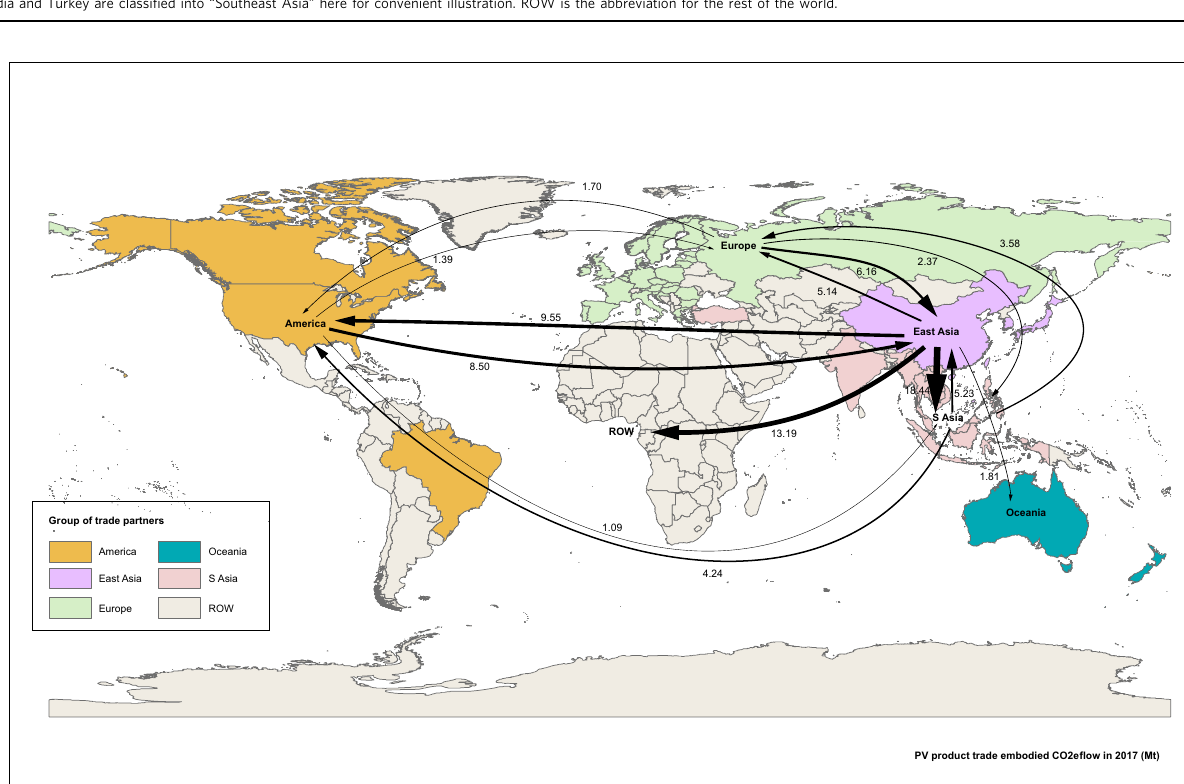
Fig. 2 Structure and fl ow of carbon dioxide equivalent (CO 2 e) embodied in the global solar photovoltaic (PV) product trade in 2017. This fi gure depicts fl ows of carbon embodied in PV product trade between regions. S Asia is the abbreviation for Southeast Asia. ROW is the abbreviation for the rest of the world. The different coloured areas show various groups of PV trade partners, i.e., purple, pink, green, blue, orange and grey areas represent from East Asia, S Asia, Europe, Oceania, America and ROW, respectively. East Asia is the largest embodied carbon exporter region, with China as the representative. Arrows show embodied carbon fl ow directions, and the thicknesses of arrows represent the relative sizes of embodied carbon fl ows (see Data sheet 6 in Source data). The base map is acquired from the open access data source of Resource and Environment Science and Data Centre, Institute of Geographic Sciences and Natural Resources Research, Chinese Academy of Sciences (CAS) 59